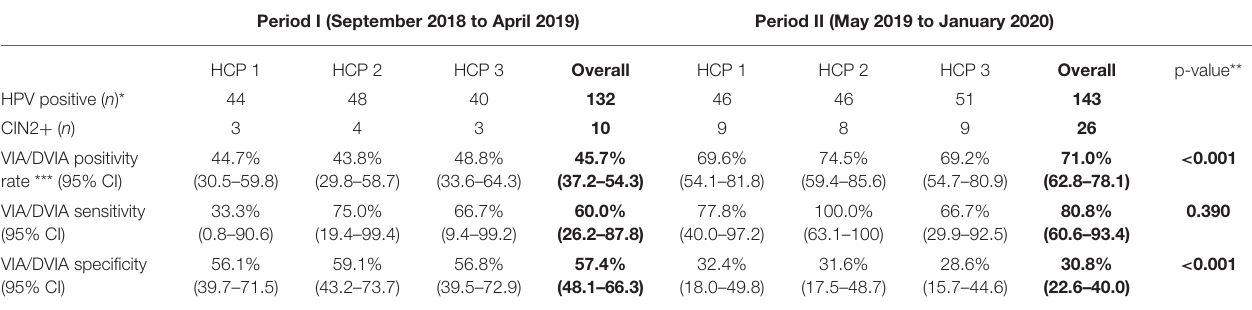
TABLE 3 | VIA sensitivity and specificity in screening to detect CIN2 + performed by HCPs.